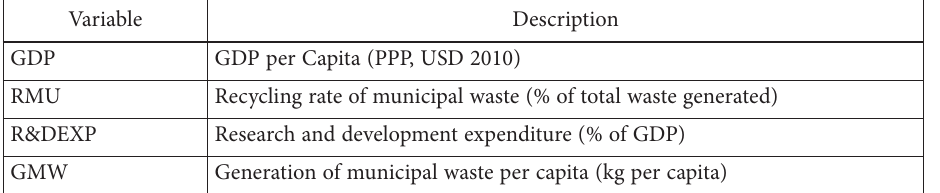
Table 1. The definitions of